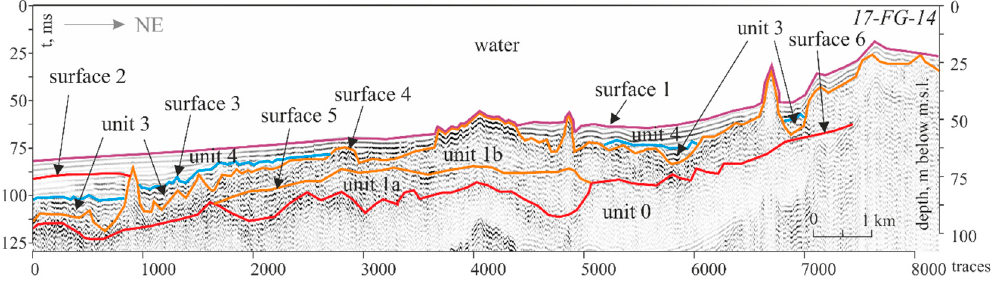
Figure 10. A seismic-reflection profile (17-FG-14) near the Moschny Island key area. Geological interpretation consists of Unit 0 = Vendian deposits, Unit 1a = lower till, Unit 1b = upper till, Unit 3 = Late Pleistocene glacio-lacustrine clays, and Unit 4 = Holocene lacustrine and marine silty-clayey muds. Surface 1 = sea bottom surface; Surface 2 = inner erosional horizon in Holocene mud, Surface 3 = top of Late Pleistocene clays, Surface 4 = top of till, Surface 5 = inner surface between two moraines. Surface 6 = top of Vendian deposits.